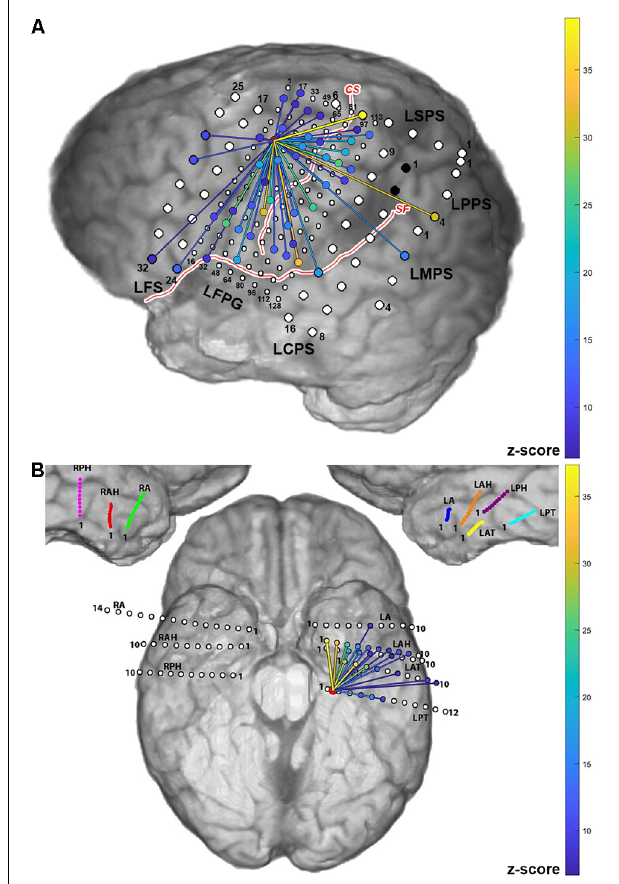
FIGURE 3 | Cortico-cortical evoked potential (CCEP) results for Patients 2 (A) and 5 (B) when stimulating individual electrode pairs (red circle between stimulated electrodes. The normalized response amplitude of the average CCEP observed at each electrode, defined as that electrode’s z -score, is used to quantify the effective connectivity between the stimulation and response site. Responses with a z -score greater than 6 were considered significant and are represented here as lines from the stimulation site (denoted in red) to the sites with significant CCEPs, colored according to the magnitude of the z -score observed at that electrode (color scale shown on